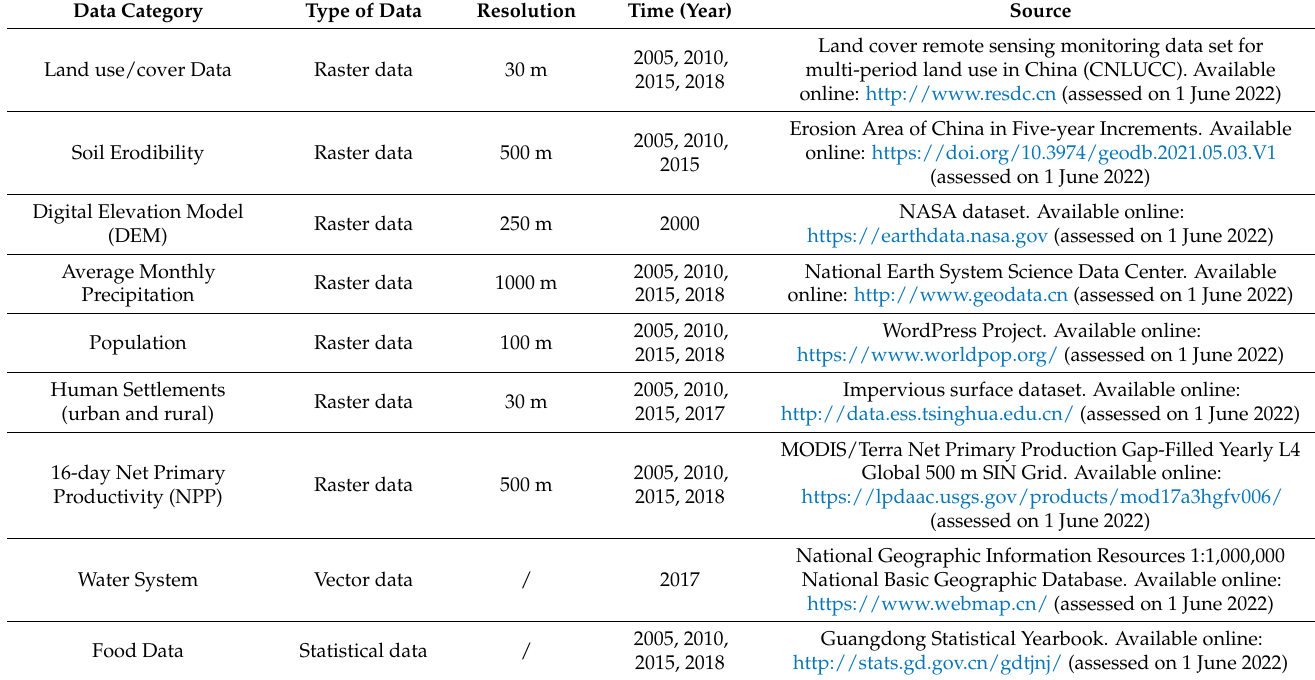
Table 1. Data source and description.